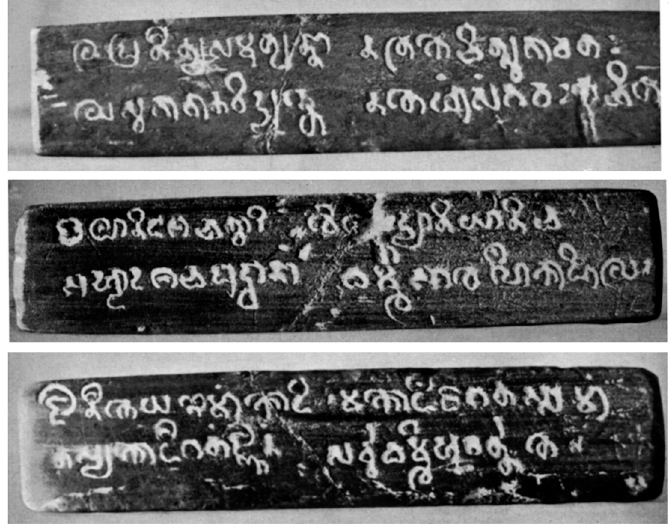
2. Three clay tablets from Bujang Valley, Kedah (7th century CE).